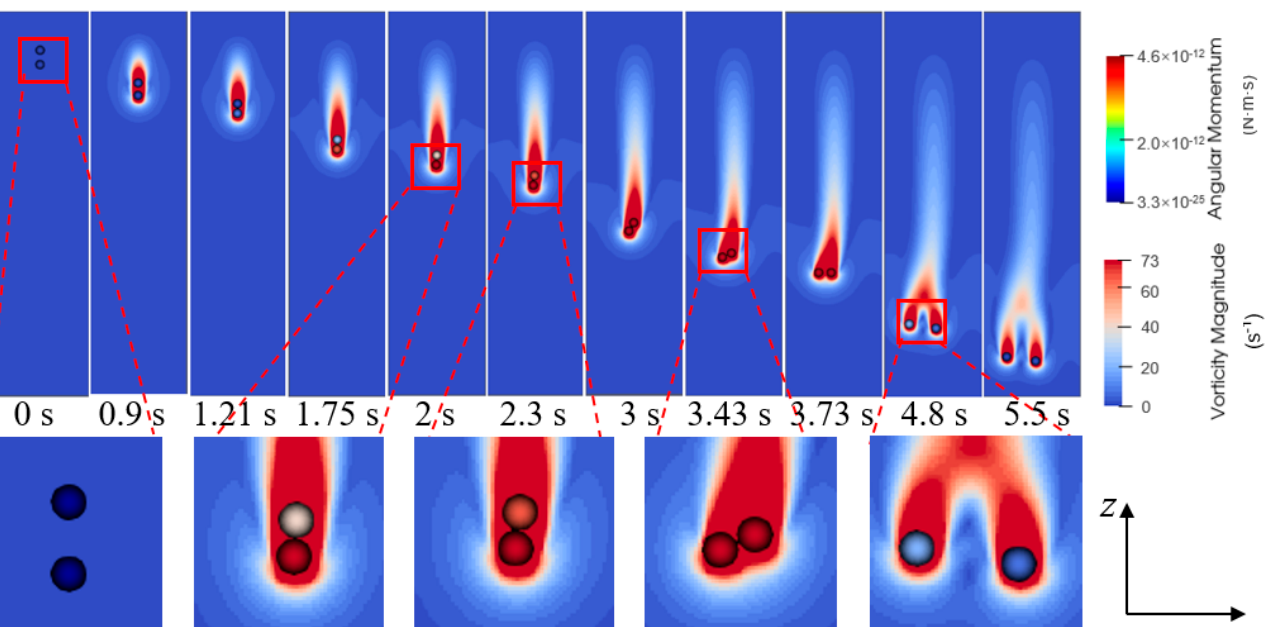
Figure 7. Distributions of pressure during settling of the two intandem particles. 3.2.2. Comparison of 2D and 3D DKT In this section, we compare the evolutions in the distance between two particles from 2D and 3D DKT. Here, d x , d y , and d z represent the x -, y -, and z -distance between the particles, respectively. d r is the surface-to-surface distance and is defined as 2